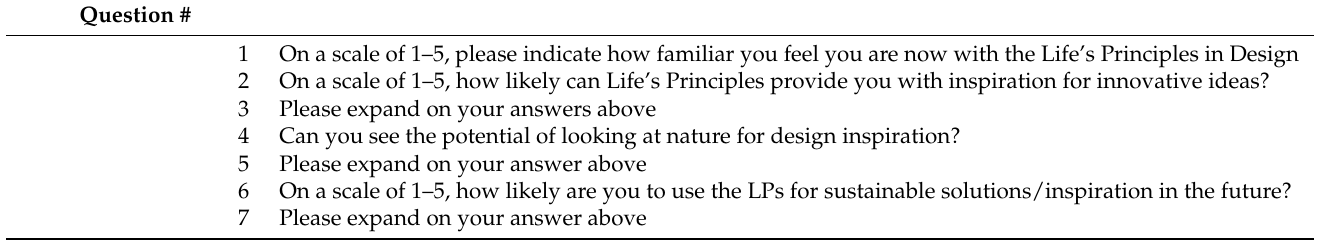
Table 2. Survey questions numbered for reference.